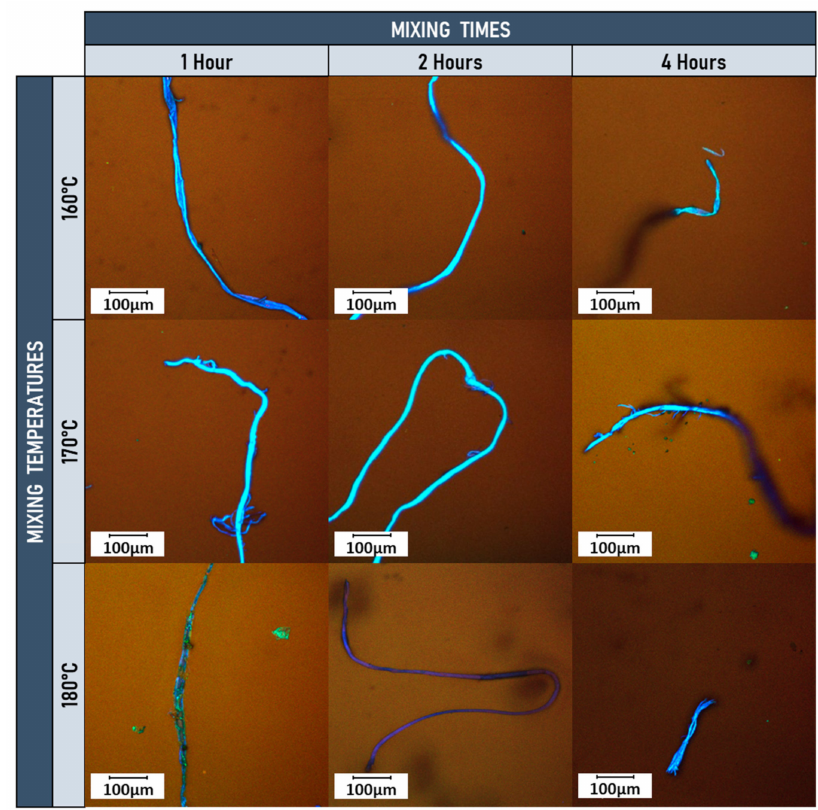
Figure 7. Fluorescence images for PFELT temperature/time modification